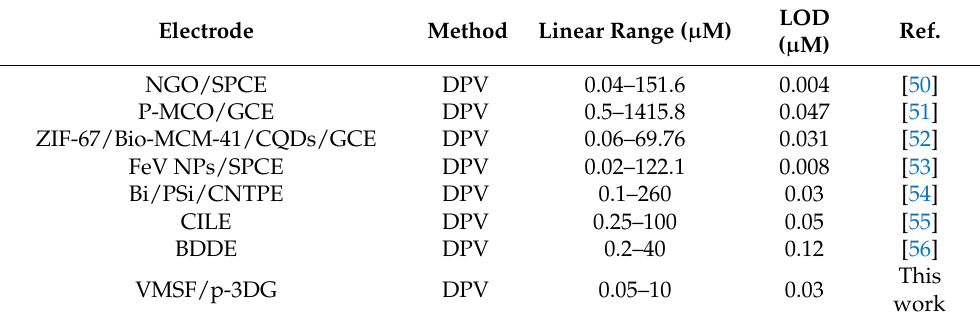
Table 1. Comparison of the preformation for detection of TR using different electrochemical